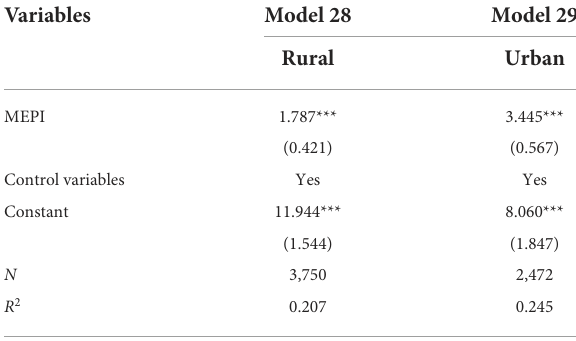
TABLE 8 Estimation results of multivariable linear regression model by type of residence.